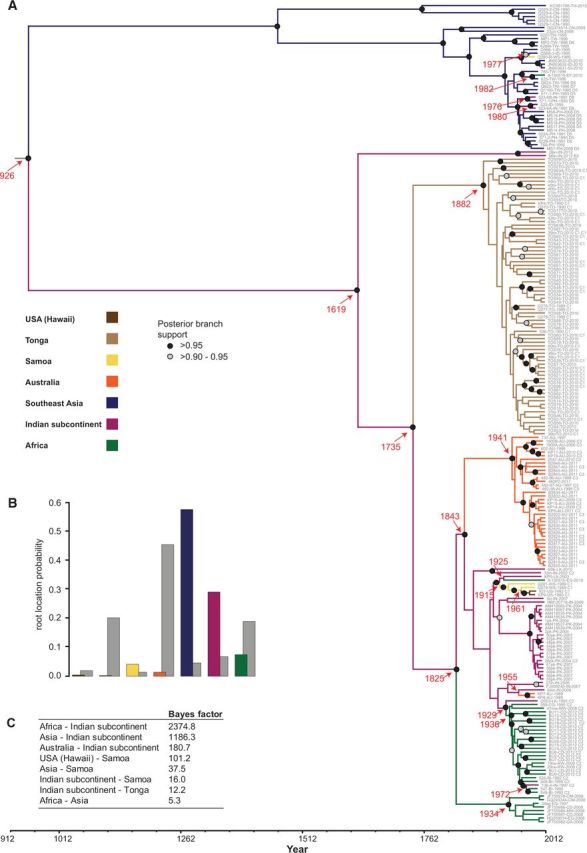
(A) An MCC tree constructed using the BBTV recombination-free CD (RF-CD) with a constant population size, strict-clock, discrete diffusion model. Branches are colored according to locations and the inferred dates (red font) of the statistically supported BBTV movement events are indicated with red arrows. Black circle on nodes indicate posterior branch support with >0.95 support and gray circles with >0.9–0.95 support. (B) Location probabilities for the root node of the tree are provided in the color-coded bar graph, and those obtained with randomization of the tip locations are shown as gray bars for each location. (C) The statistically supported epidemiological linkages between locations and their associated BF support values inferred using the Bayesian discrete diffusion phylogeography model are summarized.